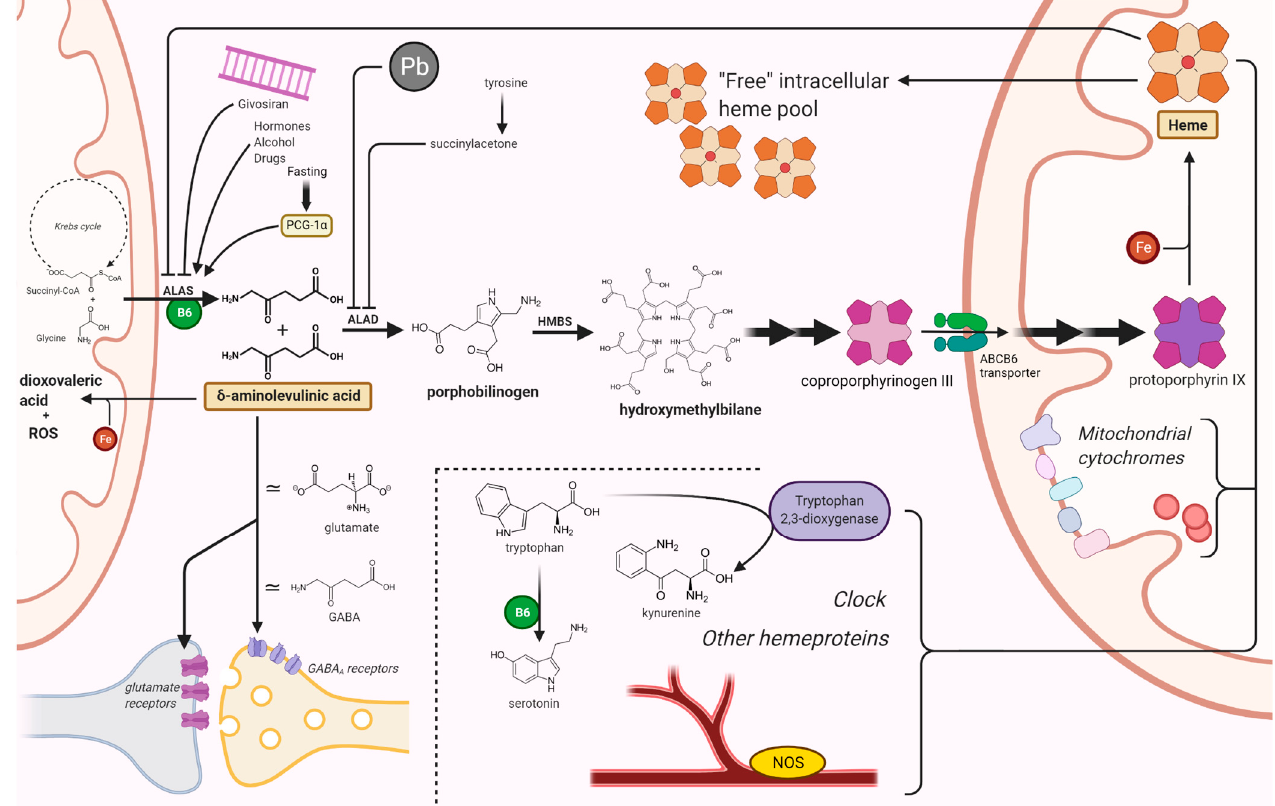
Figure 1. Mechanisms of neuronal damage in acute hepatic porphyrias . ALAS condenses glycine and succinyl ‐ CoA into ALA, in the first step of the biosynthesis of heme. After an initial series of reactions in the cytosol, coproporphyrin III is imported in mitochondria by ABCB6, a homodimeric porphyrin transporter located in the outer mitochondrial membrane. ALAS is induced by porphyrinogenic stimuli (e.g., fasting, alcohol, or certain drugs) which supposedly induce an increased metabolic demand for heme. In particular, fasting induces ALAS1 expression via the peroxisome proliferator ‐ activated receptor γ coactivator 1 α (PGC ‐ 1 α ). Lead and succinyl acetone cause a porphyria ‐ like picture since they inhibit ALAD. Acute intermittent porphyria, the most common AHP, is an autosomal dominant disease caused by an abnormal function of HMBS. ALA and (in most cases) PBG accumulate in patients with acute porphyrias during neurovisceral attacks. Givosiran, a siRNA ‐ based drug for the treatment of AHPs, acts by impairing ALAS mRNA translation in the liver. Among other toxic effects, ALA undergoes auto ‐ enolization to yield the highly reactive dioxovaleric acid (DOVA) and other oxidant species; it also interferes with GABA and glutamate receptors. Lack of heme has pleiotropic effects on cytochromes, nitric oxide synthases, tryptophan 2,3 ‐ dioxygenase, and several other hemeprotein; it may also affect the regulatory functions of the intracellular ”free” heme pool. Pyridoxal phosphate figures among the factors involved in this highly connected network of reactions. Other possible mechanisms of neuronal damage are described in the text. ABCB6, ATP ‐ binding cassette transporter B6; ALA, δ ‐ aminolevulinic acid; ALAD, ALA dehydratase; ALAS, ALA synthase; B6, pyridoxal phosphate; Fe, iron; GABA, γ ‐ aminobutyric acid; HMBS, hydroxymethylbilane synthase; NOS, nitric oxide synthase; Pb, lead. Created with BioRender.com (last accessed date: 22 November 2021).